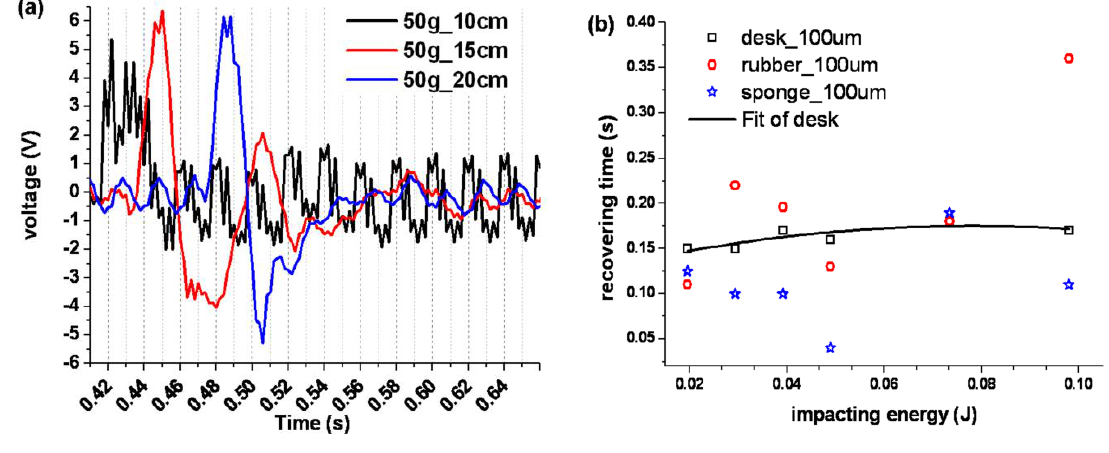
Figure 4. Comparison of the recovery time of the PVDF sensor after suffering impact, when it was supported by three backstops which were desk, rubber and sponge,